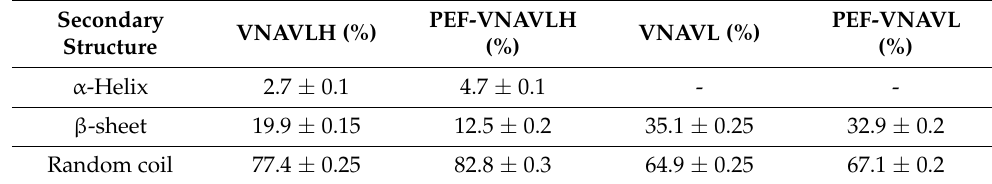
Figure 3. CD spectra of peptides before and after PEF treatment. Table 1. The content changes of secondary structure of peptides before and after PEF